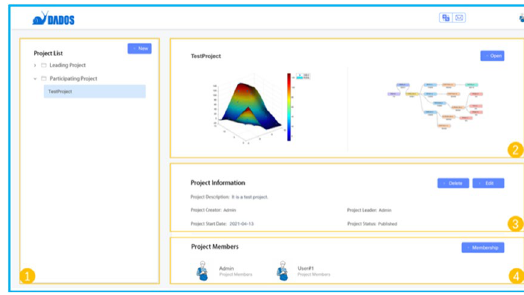
Figure 4 The project management screen of